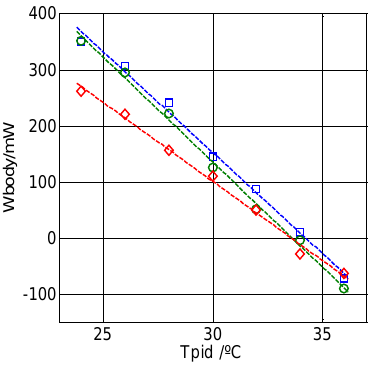
Figure 13. Three measurements made on the left wrist of a healthy, 58-year-old male subject on three different days (squares, circles and diamonds) for different thermostat temperatures T pid ( T room = 26°C).